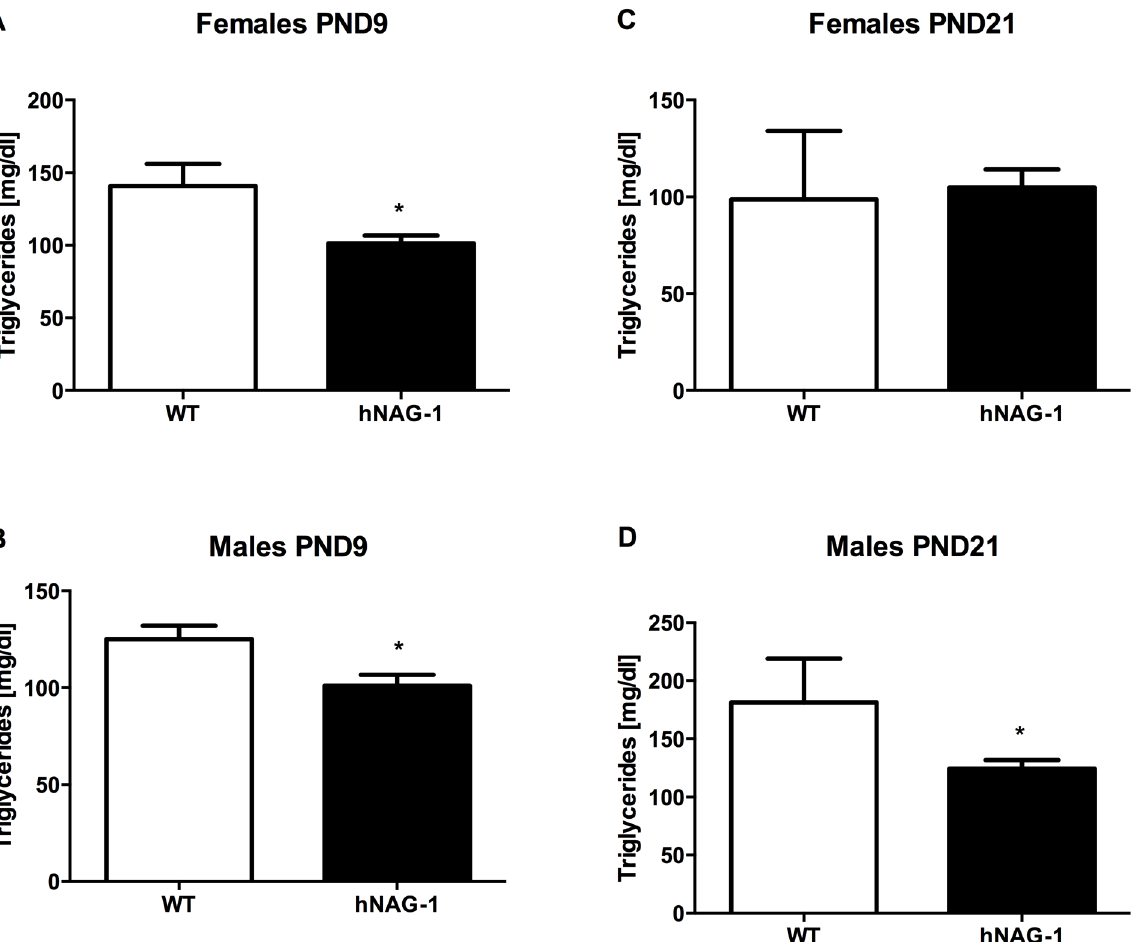
Fig 4. Pup serum shows reduced triglycerides during mid-lactation (PND9) and at weaning (PND21) from hNAG-1 dams compared to WT dams. CD-1 pups were cross-fostered with WT or hNAG-1 dams on PND2 so the pups are all WT CD-1 pups. Pup serum was examined for Triglycerides at PND 9 (A&B) or PND21 (C&D). Data shown is average +/- SEM. Mann-Whitney statistical test was done to compare each line to WT. * , p < 0.05.